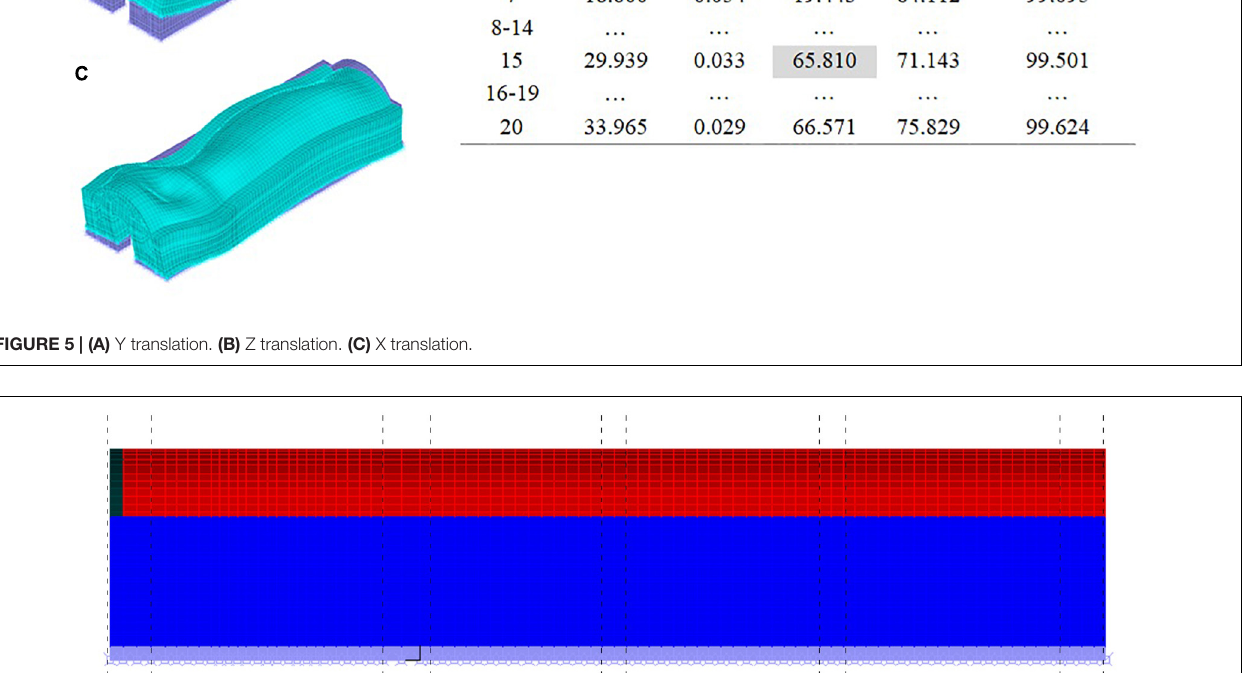
= 0.653 MPa; t = 5.023 MPa, k